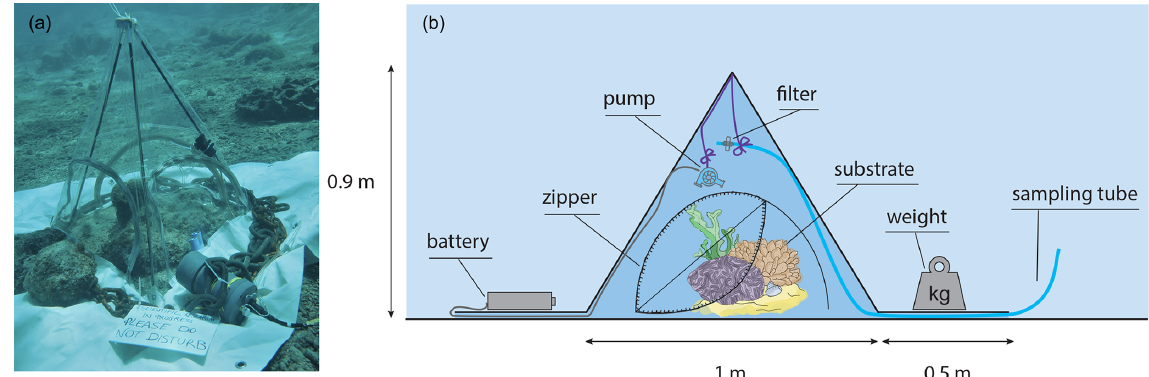
Figure 1. The tent incubation set-up used. (a) Photograph depicting the tent incubation during the experiments. (b) Schematic cross section of the employed set-up for enclosing a small patch of reef. A battery powered mixing propeller for maintaining water circulation and analysers for salinity ( S ), temperature ( T ), oxygen (O 2 ), and light (PAR) are located inside the tent. Outside the enclosure other S , T , and PAR analysers were placed, as well as the battery for the pump. Sampling of exterior and interior water (though sampling tube) was performed by divers using large volume syringes. Zippers allow for opening of tent windows for re-equilibrating the interior to the exterior conditions between incubations.